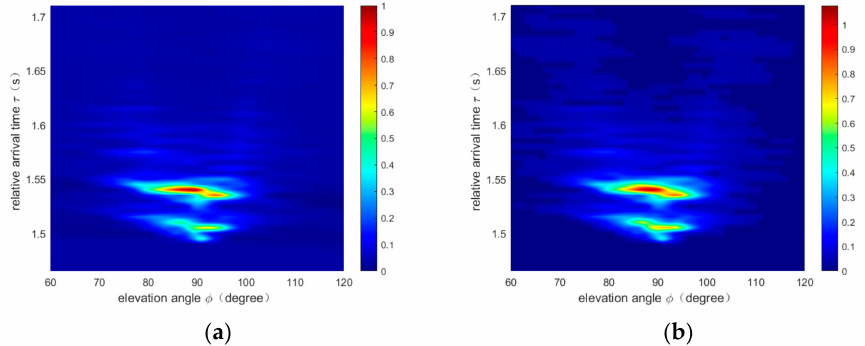
Figure 9. Preprocessing result with a threshold of 0.1; ( a ) original beam-time image, ( b ) preprocessed- input